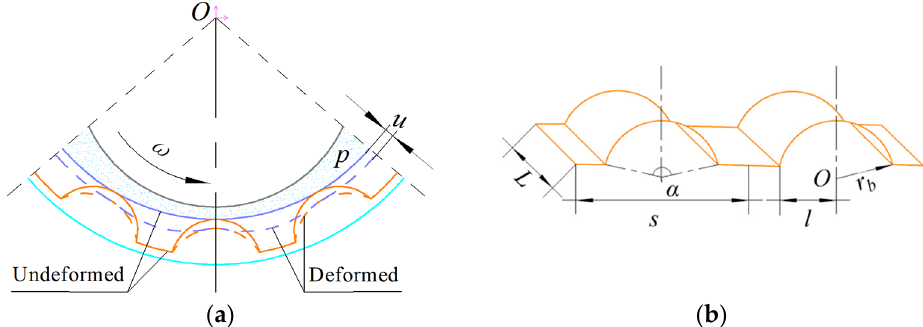
Figure 2. ( a ) Deformation of the foil. ( b ) Structural parameters of the bump foil.